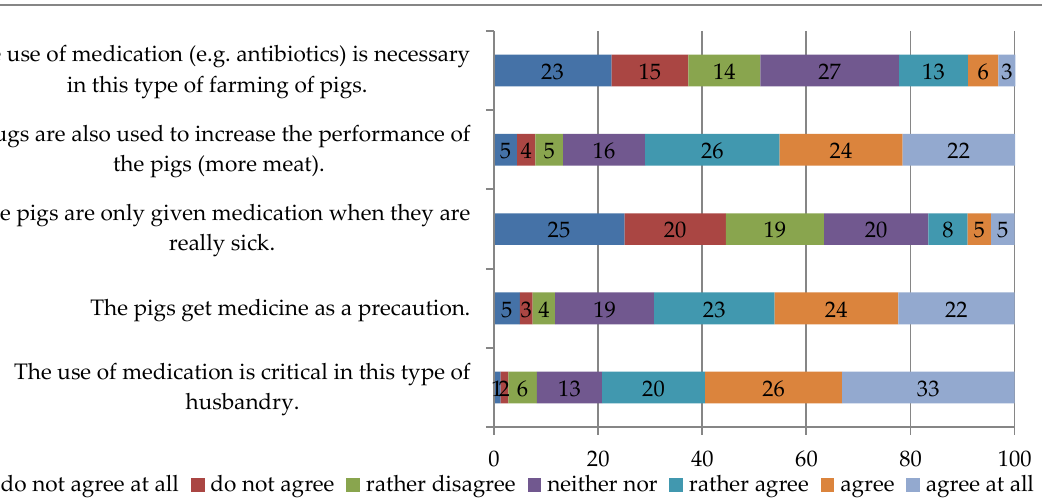
Figure 6. Frequency distribution of the statements regarding surgical interventions.